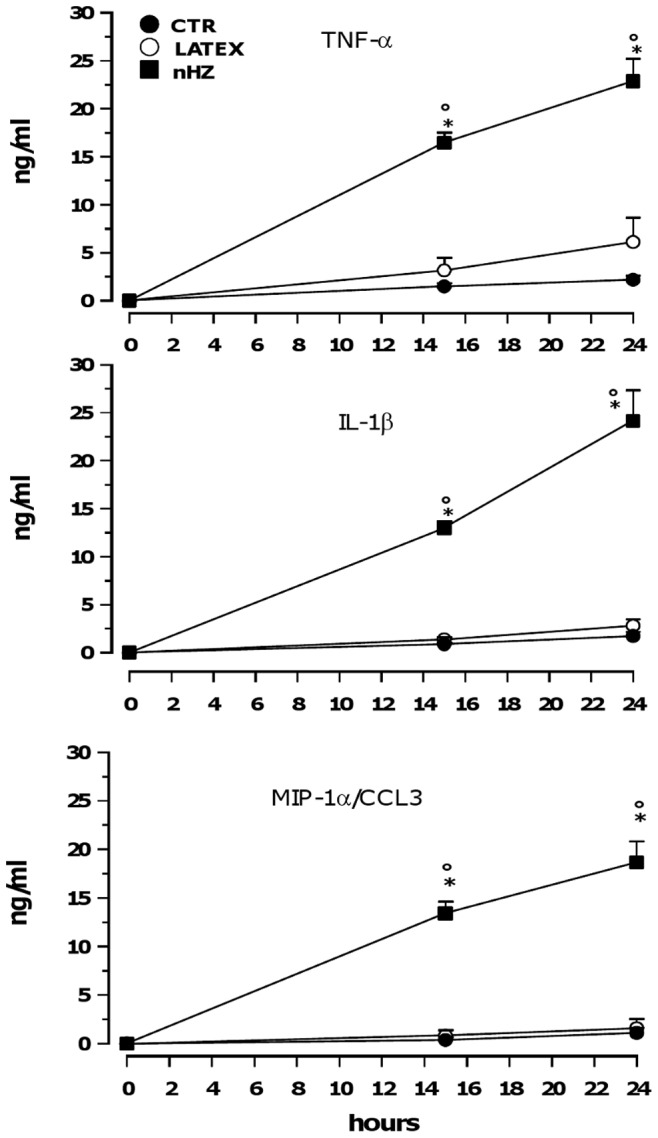
nHZ enhances production of TNF-α, IL-1β, and MIP-1α/CCL3 by human adherent monocytes.Cells were left unfed (CTR), fed with latex particles (LATEX), or fed with nHZ (nHZ) for 2 h; therefore, production of TNF-α (upper panel), IL-1β (central panel), and MIP-1α/CCL3 (lower panel) was monitored in cell supernatants 0, 15 and 24 h after the end of phagocytosis. Data are means+SEM of three independent experiments. Production of pro-inflammatory molecules is indicated as ng/ml. All data were evaluated for significance by ANOVA. Vs control cells (CTR) *p<0.0001; Vs LATEX-fed cells (LATEX) °p<0.0001.